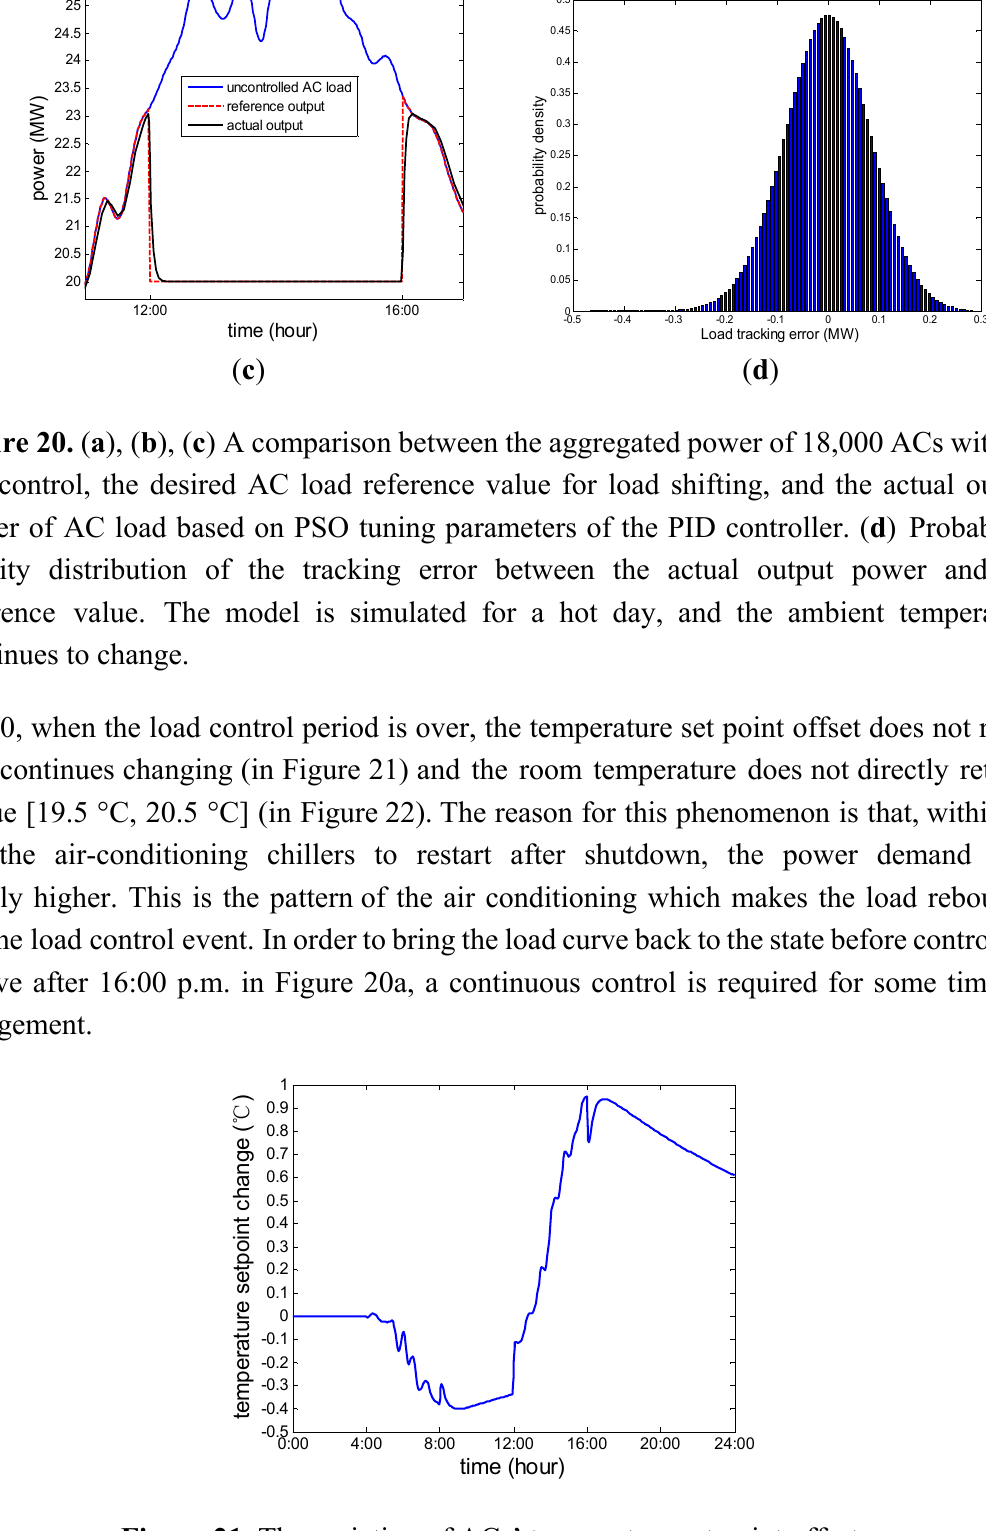
Figure 21. The variation of ACs’ temperature set point